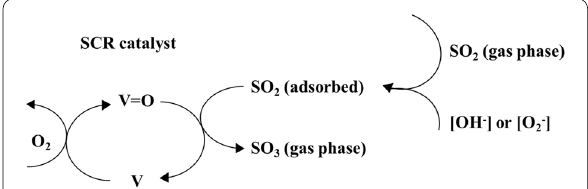
Fig. 11 Catalytic oxidation process of SO 2 ‑SO 3 under the action of V